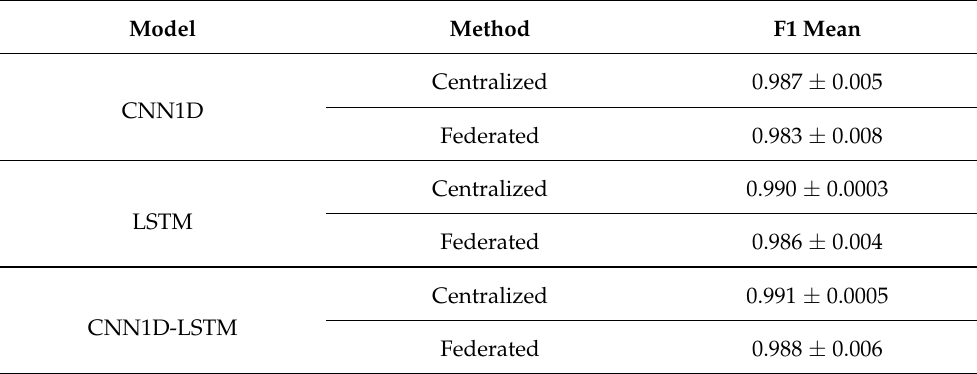
Table 6. Performance comparison by learning methods about the HDFS dataset.